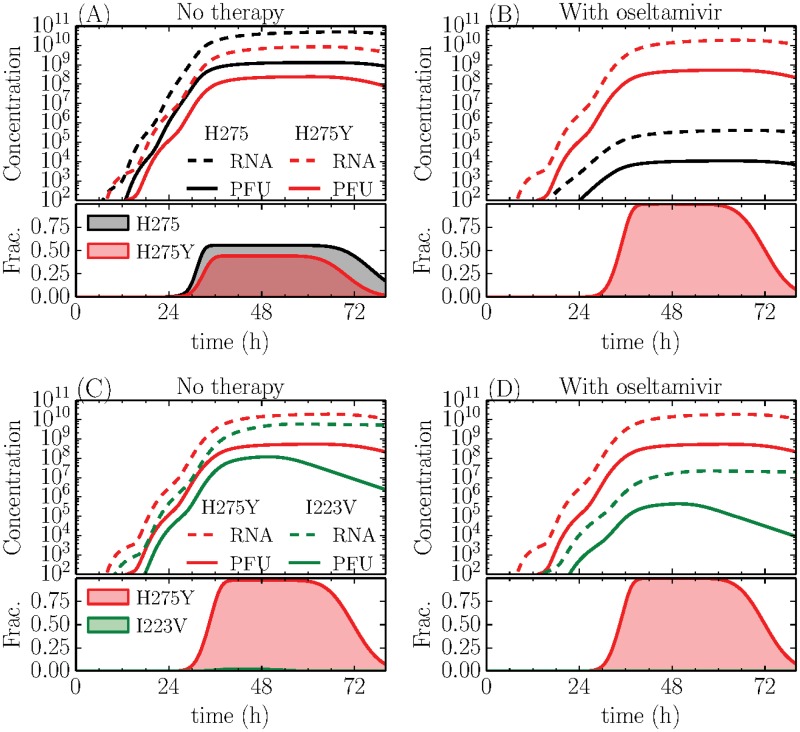
Simulated competition between the wild-type, MUT-H275Y and MUT-I223V strains.The infectious (PFU/mL) and total (RNA/mL) viral load (top), and the fraction of infectious cells infected by each strain (bottom) are shown. (A) Without therapy, the fitness of the WT and MUT-H275Y strains is comparable. (B) In the presence of oseltamivir, the WT has a replicative disadvantage over the MUT-H275Y. (C) Without therapy, the MUT-H275Y strain already has a fitness advantage over the MUT-I223V strain. (D) In the presence of oseltamivir, this advantage is increased.